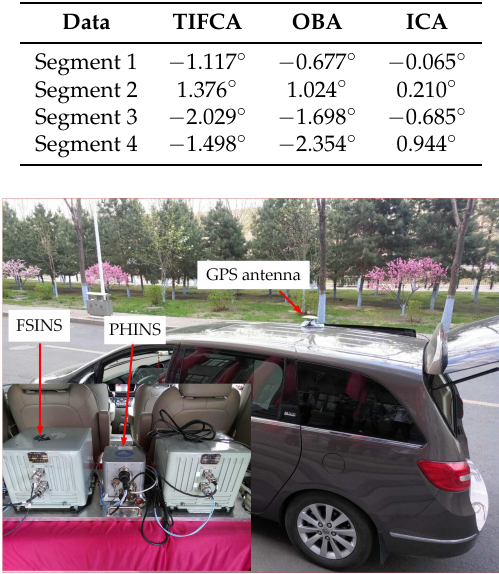
Figure 5. The FSINS and PHINS for the experiment.